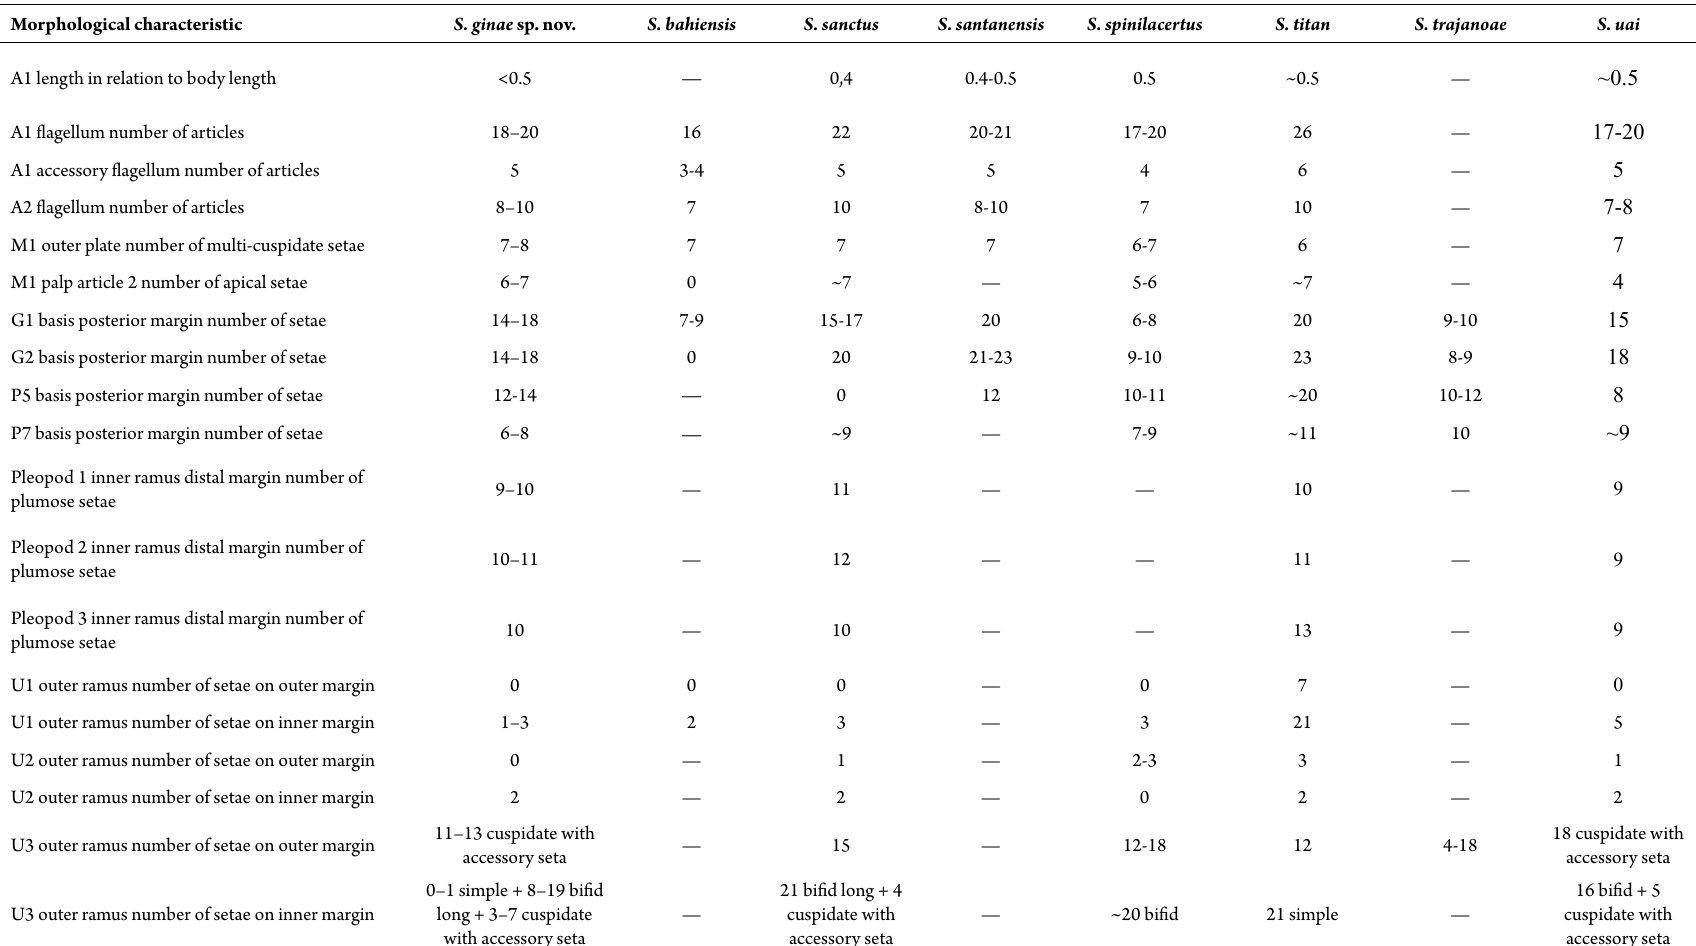
Table 1. Morphological characteristics of the species of the genus Spelaeogammarus from Brazil. Legend: “—” not specified or unidentified. Morphological